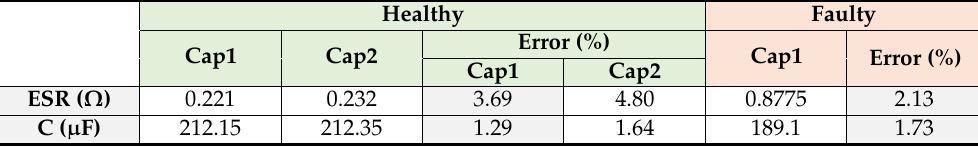
Figure 11. Voltage and current spectra of Cap1 in both states (healthy and faulty). Table 3. Estimated ESR and C values for Cap1 and Cap2 (healthy capacitors) and Cap1 (faulty capacitor). Healthy Faulty Error (%) Cap1 Cap2